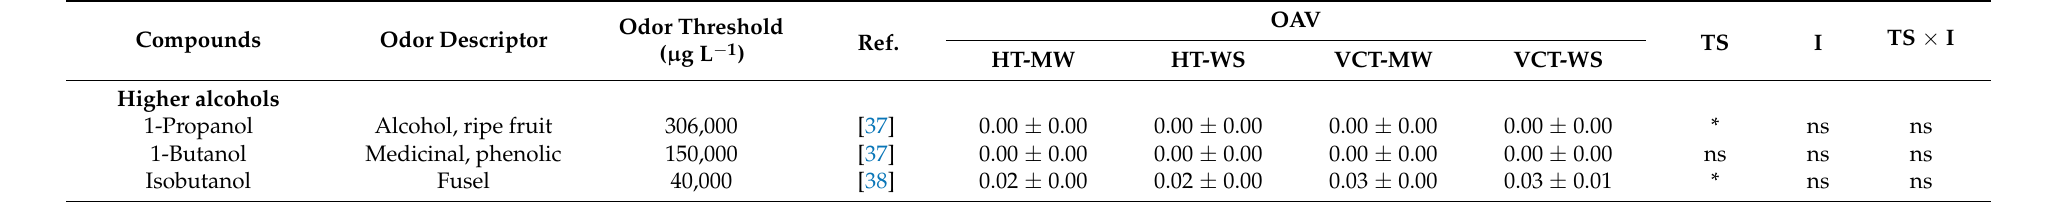
Table 7. Odor activity values (OAV) of Maturana Blanca wines obtained by the different